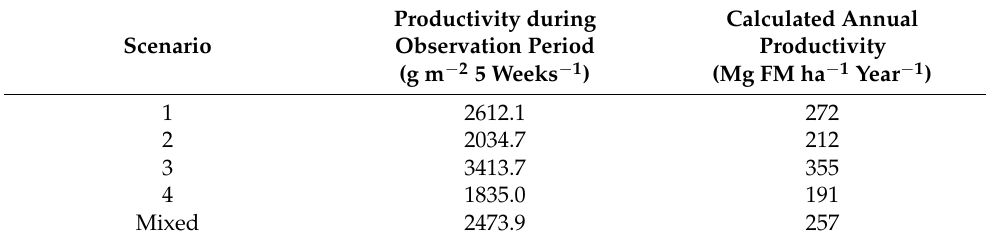
Table 11. Scenario analysis: Productivity in g m − 2 5 weeks − 1 and Mg FM ha − 1 year − 1